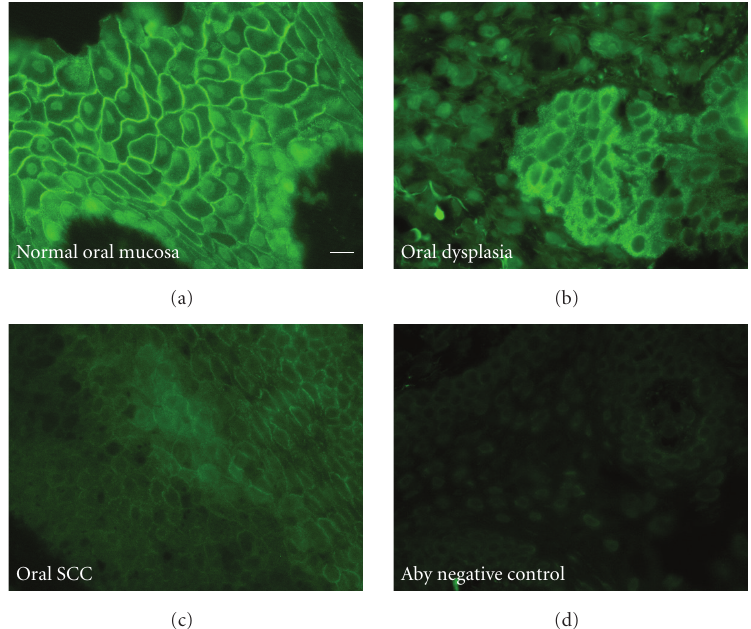
Figure 2: Representative antidesmoplakin staining of oral tissues. Antidesmoplakin monoclonal antibody (10F6) was used to stain normal oral mucosa (a), dysplastic oral mucosa (b), and oral squamous cell carcinoma (c). Normal oral mucosa processed in the absence of primary antibody serves as a negative control (d). The scale bar in panel A corresponds to 20 μ